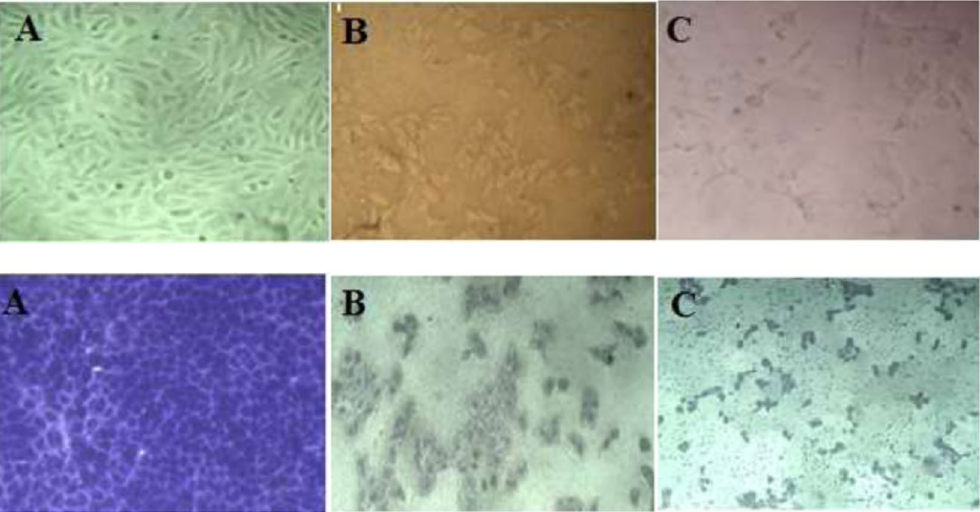
Figure 11. Microscopic evaluation of the effect of the O. limnetica extract ( A ), O-AgNPs ( B ) as well as the silver nitrate alone ( C ) in a bright field (top raw) or after staining with crystal violet (lower raw) on MCF-7 cells at concentration of 120 µ